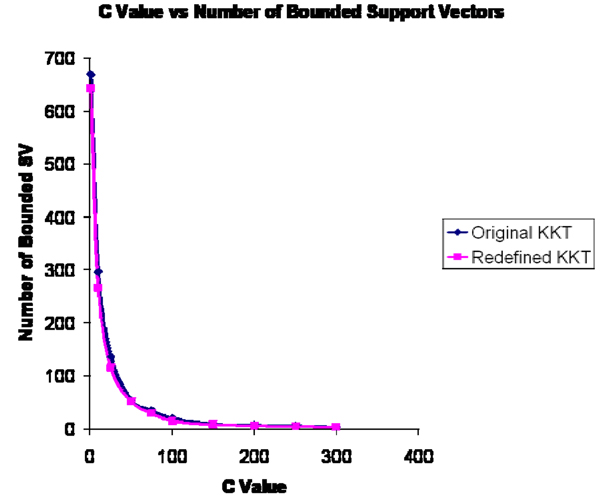
The number of bounded support vectors (BSV) as a function of 'C' value. There are many BSVs for very low values of 'C' and very few BSVs for large values of 'C'. Thus we can say that the number of BSVs plays a vital role in the speed of convergence of the algorithm.